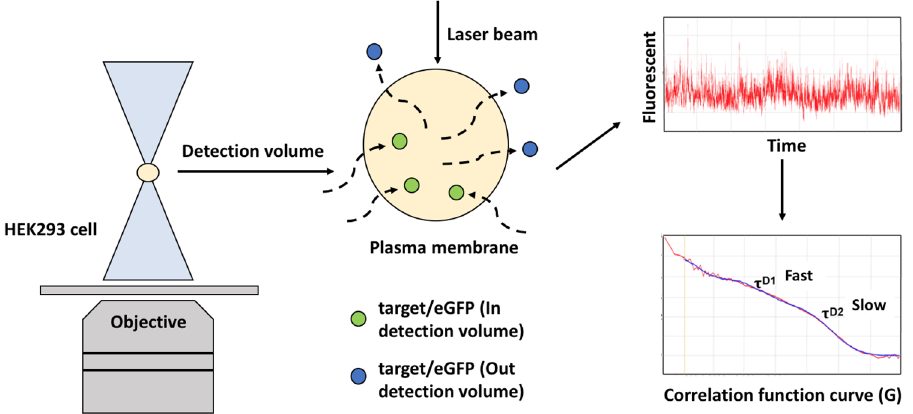
Figure 2. The construction of Fluorescence Correlation Spectroscopy (FCS). Combining confocal microscopy with FCS to monitor protein dynamics in living cells, the plot represents the fluctuations in the detected fluorescence intensity arising from individual fluorescent molecules (the green dots within detection volume), and it is plotted as a function of time. During imaging (center panel), eGFP diffuses in (green) and out (blue) of the detection volume in both directions. Only eGFP located within the detection volume are measured at any given